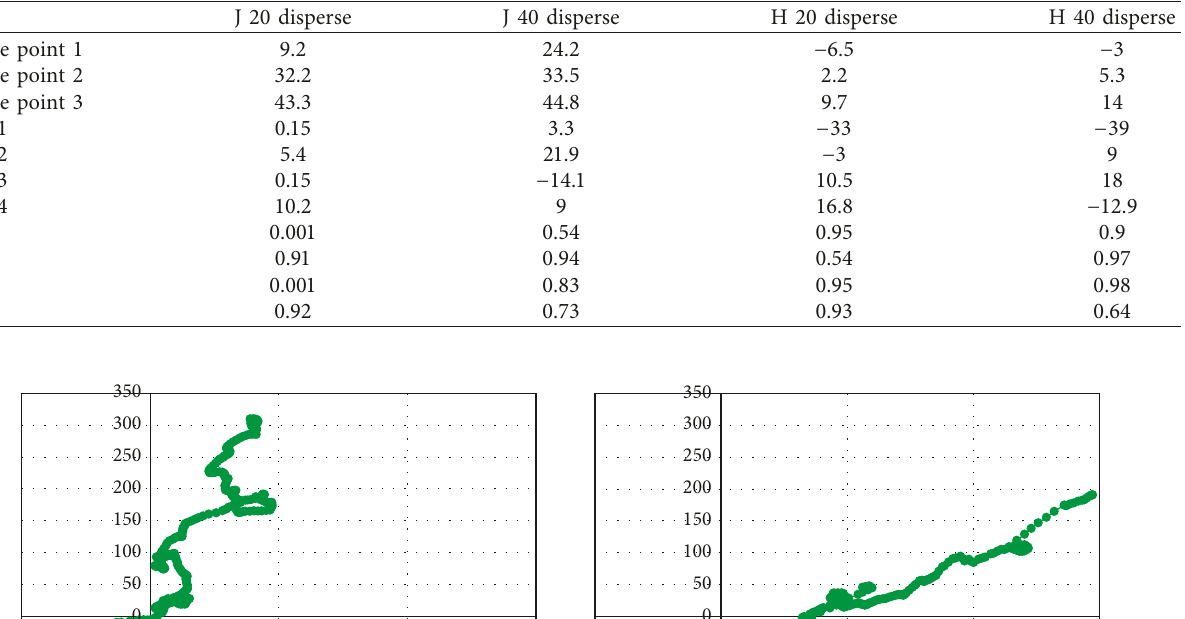
Table 5: Results of change point analysis for dispersion of 20 and 40dB Z regions with time of change point in hours after landfall, slope of trend line in between each change point in km · hr − 1 , and the coefficient of determination for each trend line.